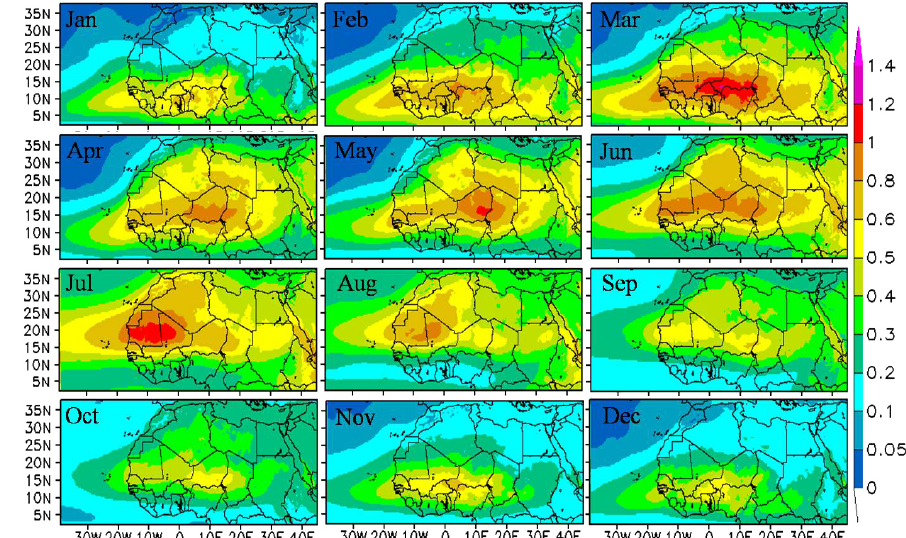
Figure 8. Monthly aerosol optical thickness (AOT) simulated by ALADIN averaged over the 2006–2010 period.